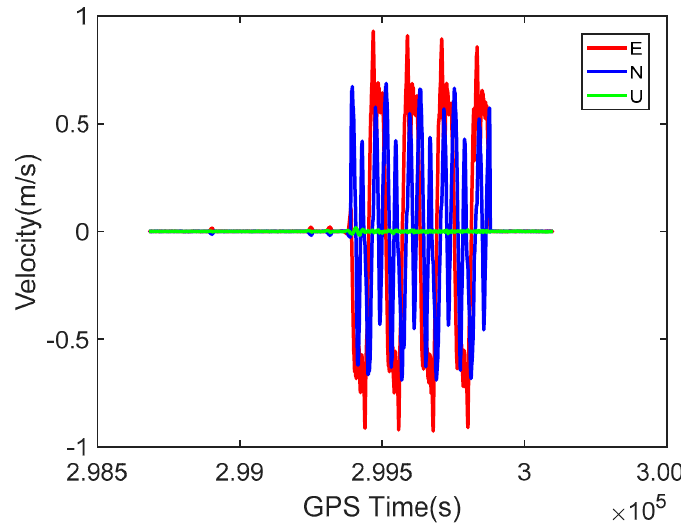
Figure 3. The velocity of the reference trajectory.